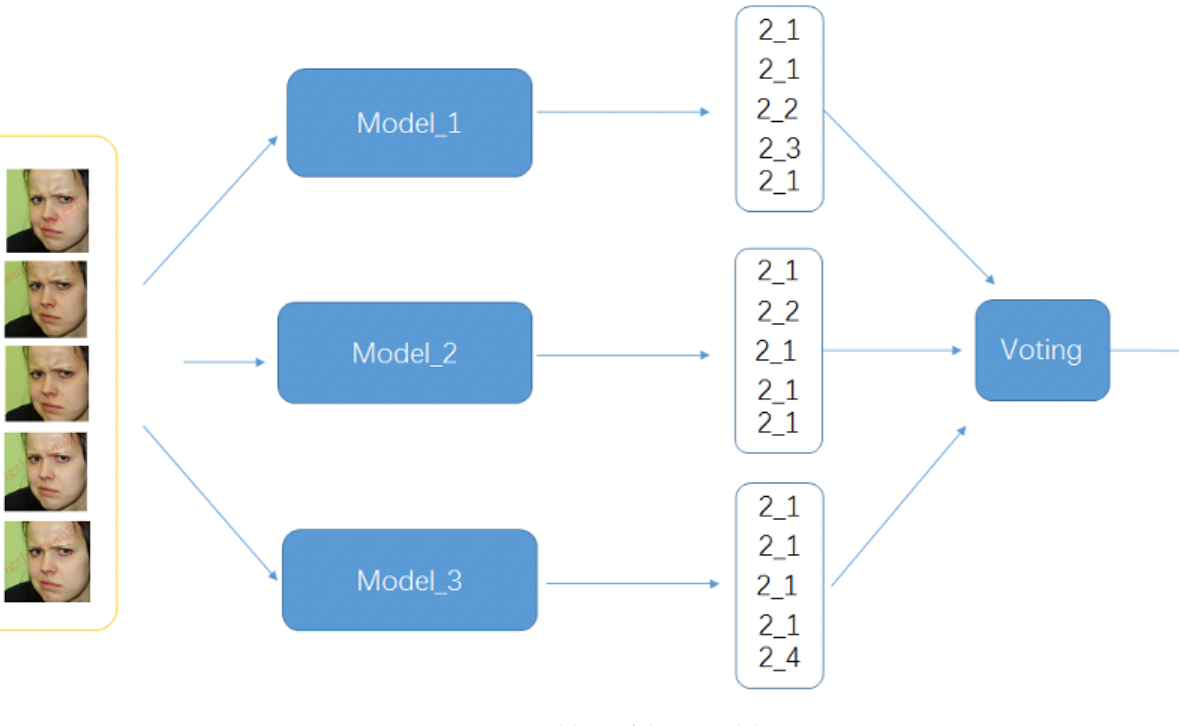
Figure 8. Assembling of three models.